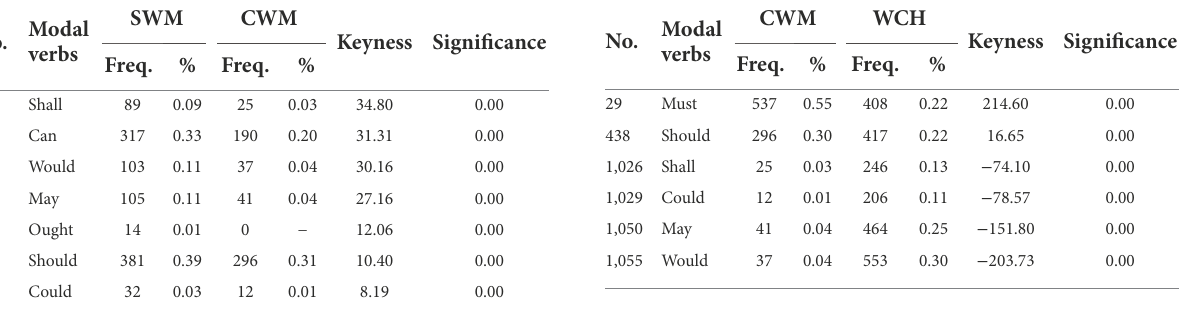
TABLE 13 Key modal verbs in CWM (in comparison with WCH).